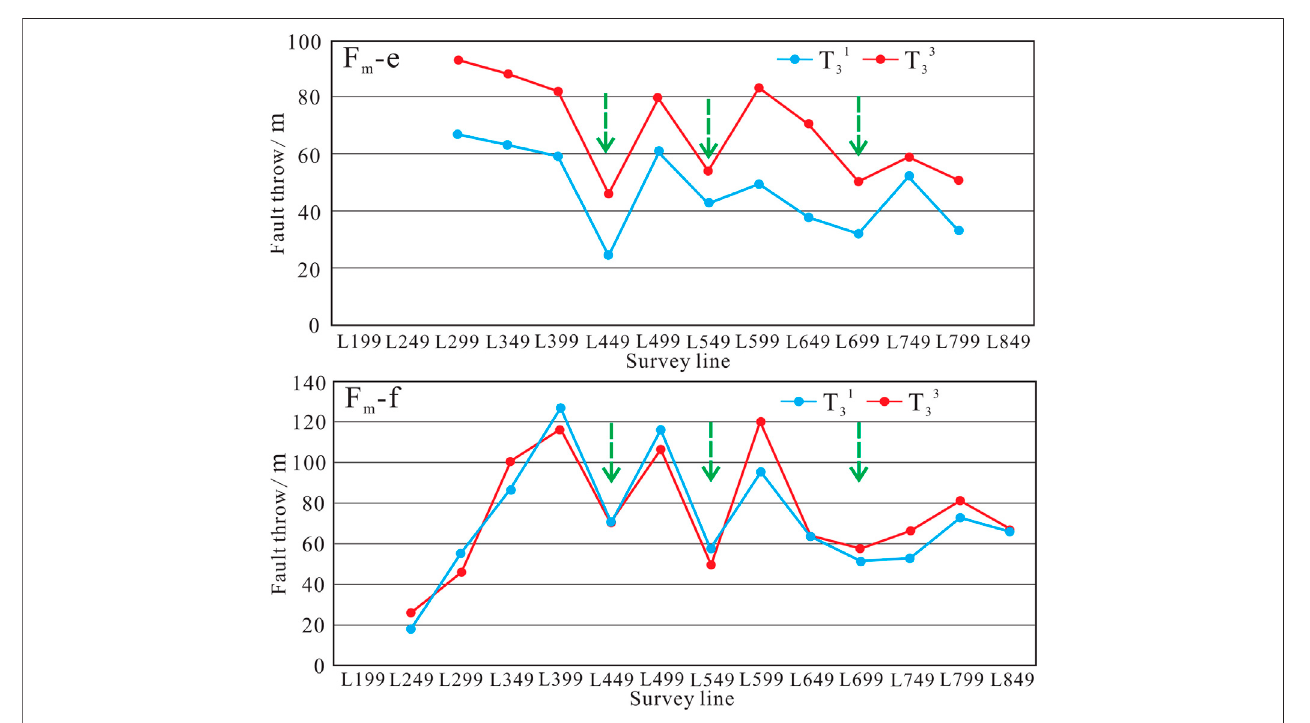
FIGURE15| Variation inthe throw ofE-W-striking main faults (F m -e and F m -f) at locations where NE-SW-strikingconcealed faults mechanicallyinteract or link with E-W-striking main faults.